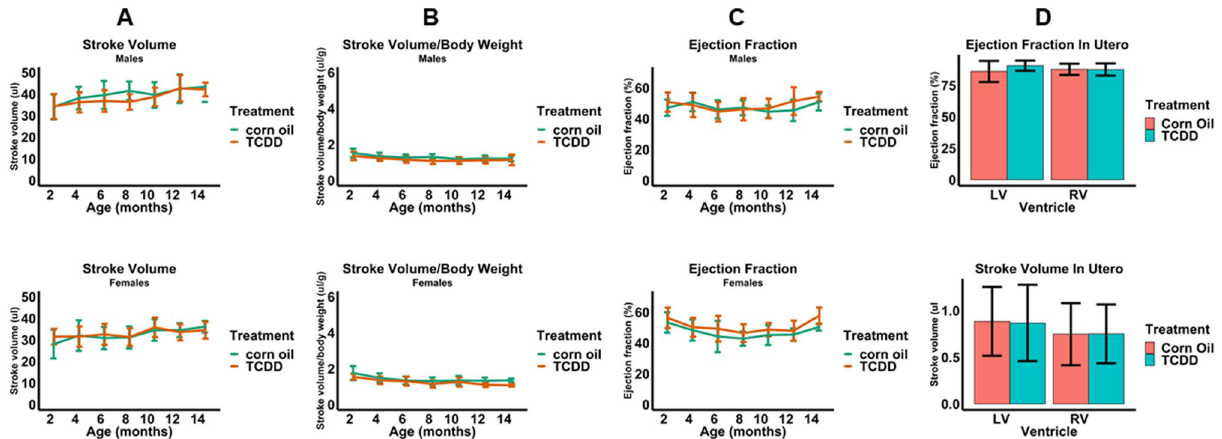
Figure 3. Echocardiographic assessment of cardiac function after continuous exposure to TCDD for 14 months. Stroke volume ( A ), stroke volume normalized to body weight ( B ) and ejection fraction ( C ) were assessed in males and females after 14 months of continuous exposure to TCDD. Ejection fraction and stroke volume were assessed after exposure to TCDD in utero at E15.5 ( D ). All data are expressed as mean +